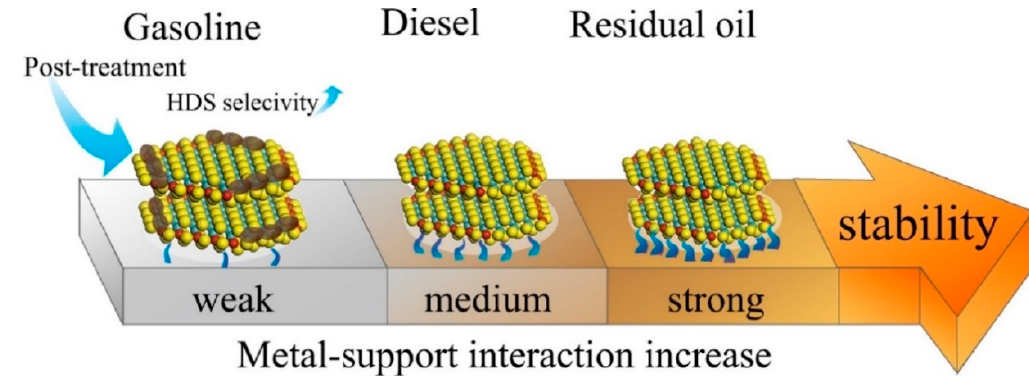
Figure 2. Metal-support interactions in hydrotreating catalysts depending on the intended use by H. Nie et al. [16].